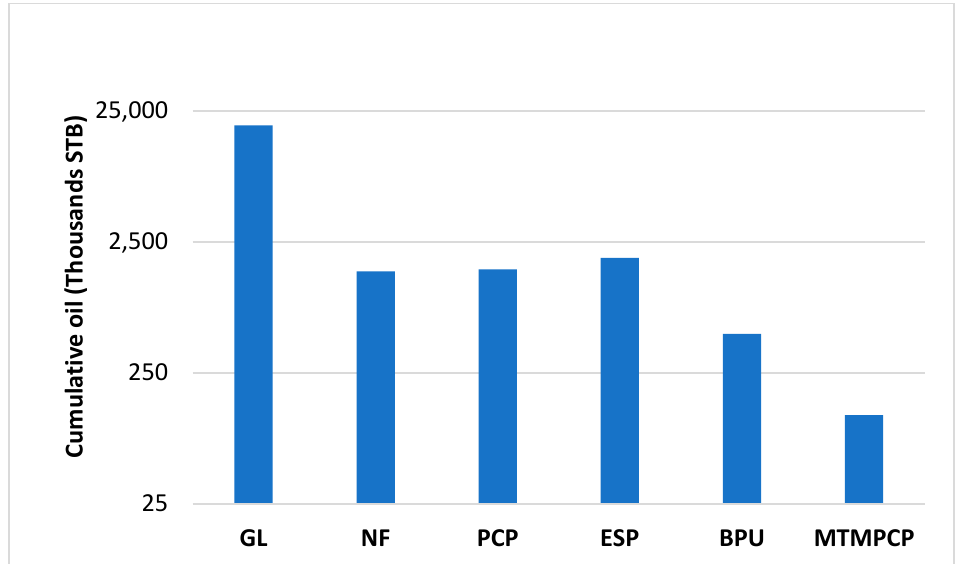
Figure 3. Cumulative oil produced by each AL according to IOR and EOR.